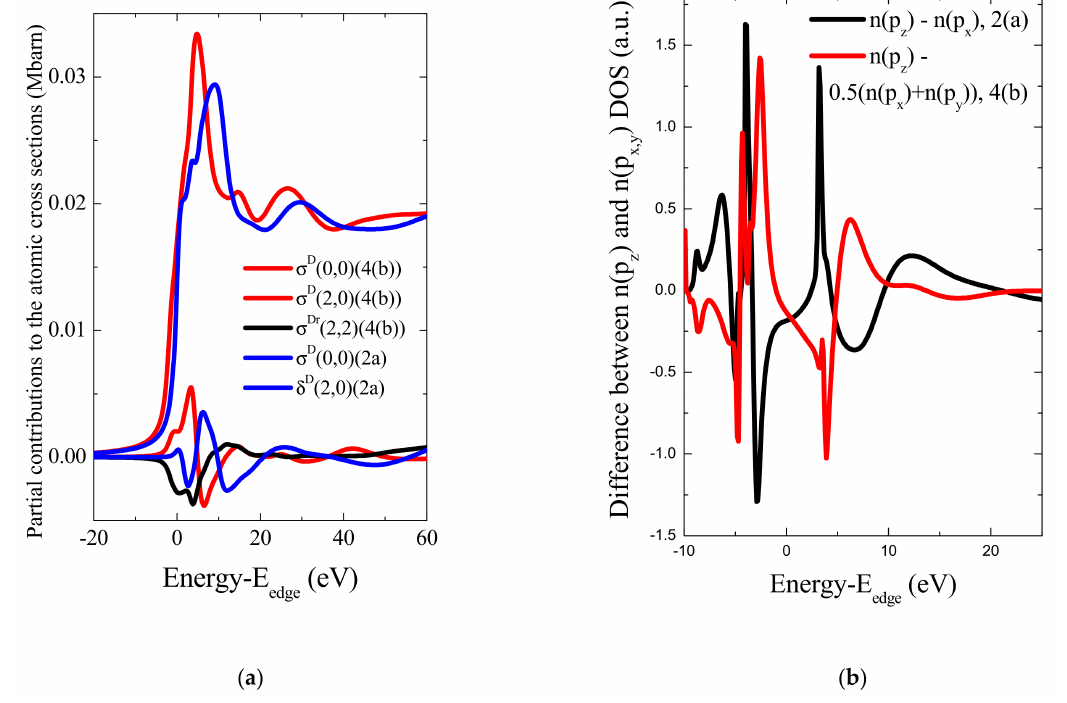
Figure 5. ( a ) Energy dependence of the coefficients describing the isotropic and anisotropic parts of the absorption coefficients of Ge atoms in two Wyckoff positions (calculated). ( b ) Difference between the p z and p x DOS for the 2(a) position of Ge and p z and in-plane p DOS for the 4(b) position of Ge. E edge = 11,113.8